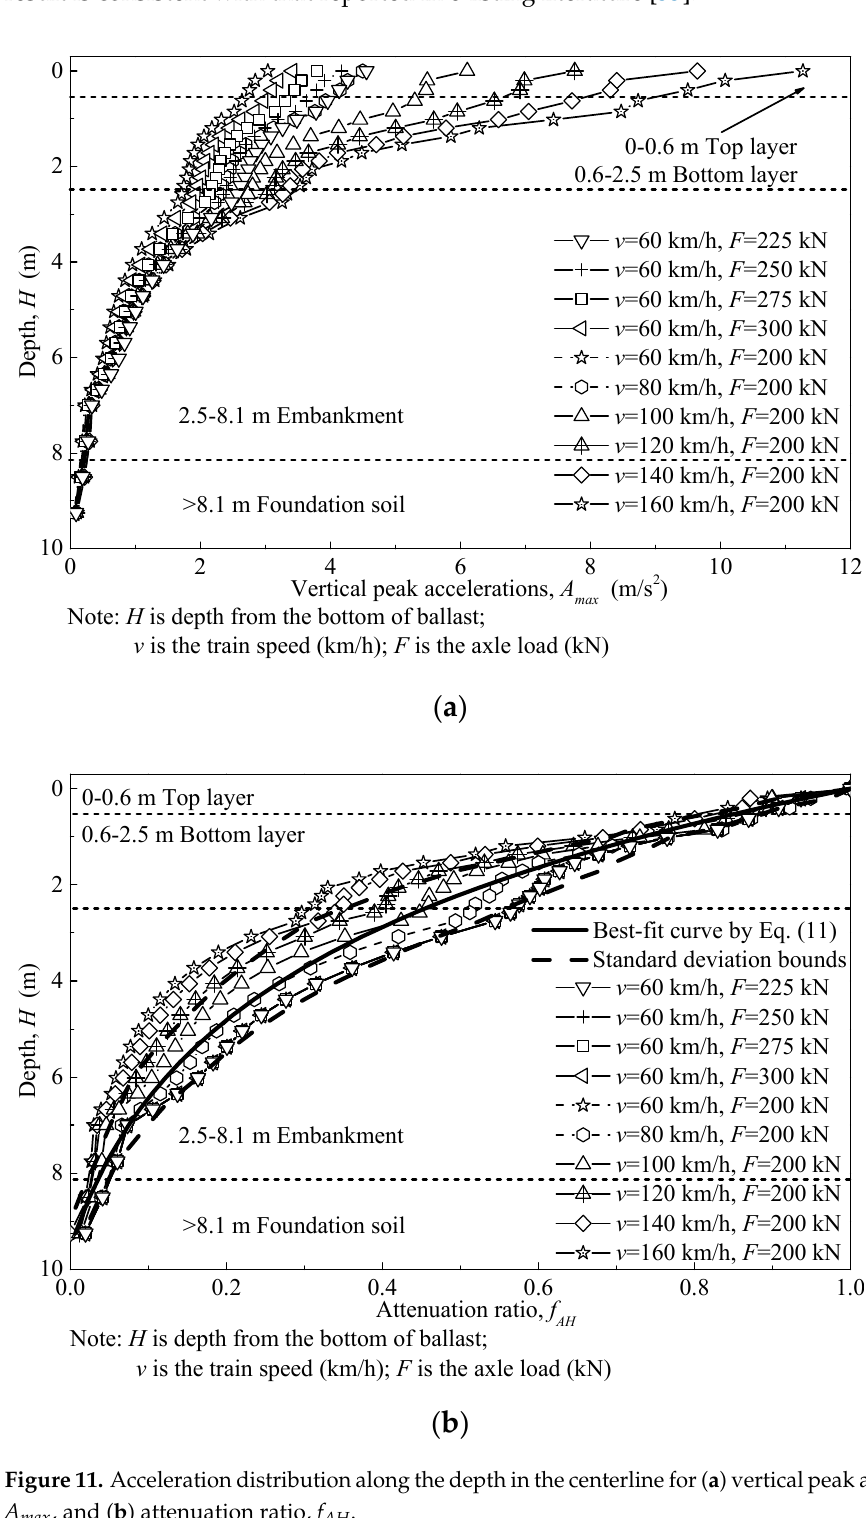
Figure 11. Acceleration distribution along the depth in the centerline for ( a ) vertical peak accelerations, A max , and ( b ) attenuation ratio, f AH .